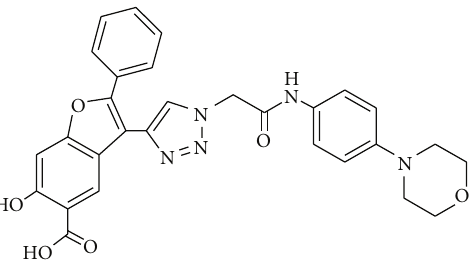
Figure 1: Benzofuran salicylic acid